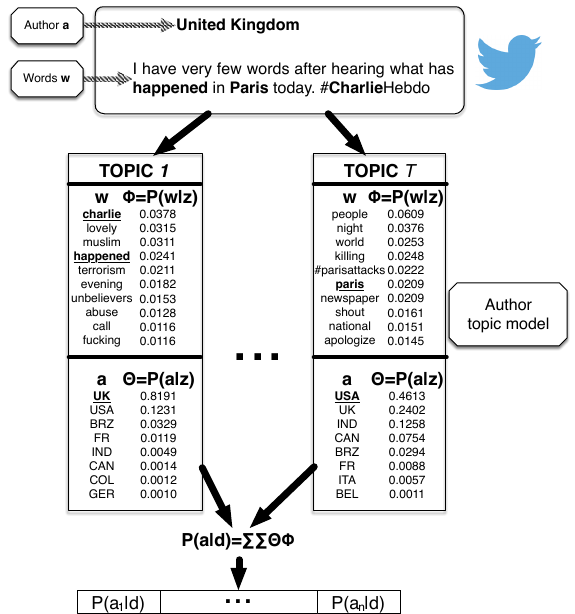
Figure 1: Example of a tweet d mapped into an author topic model of size T .